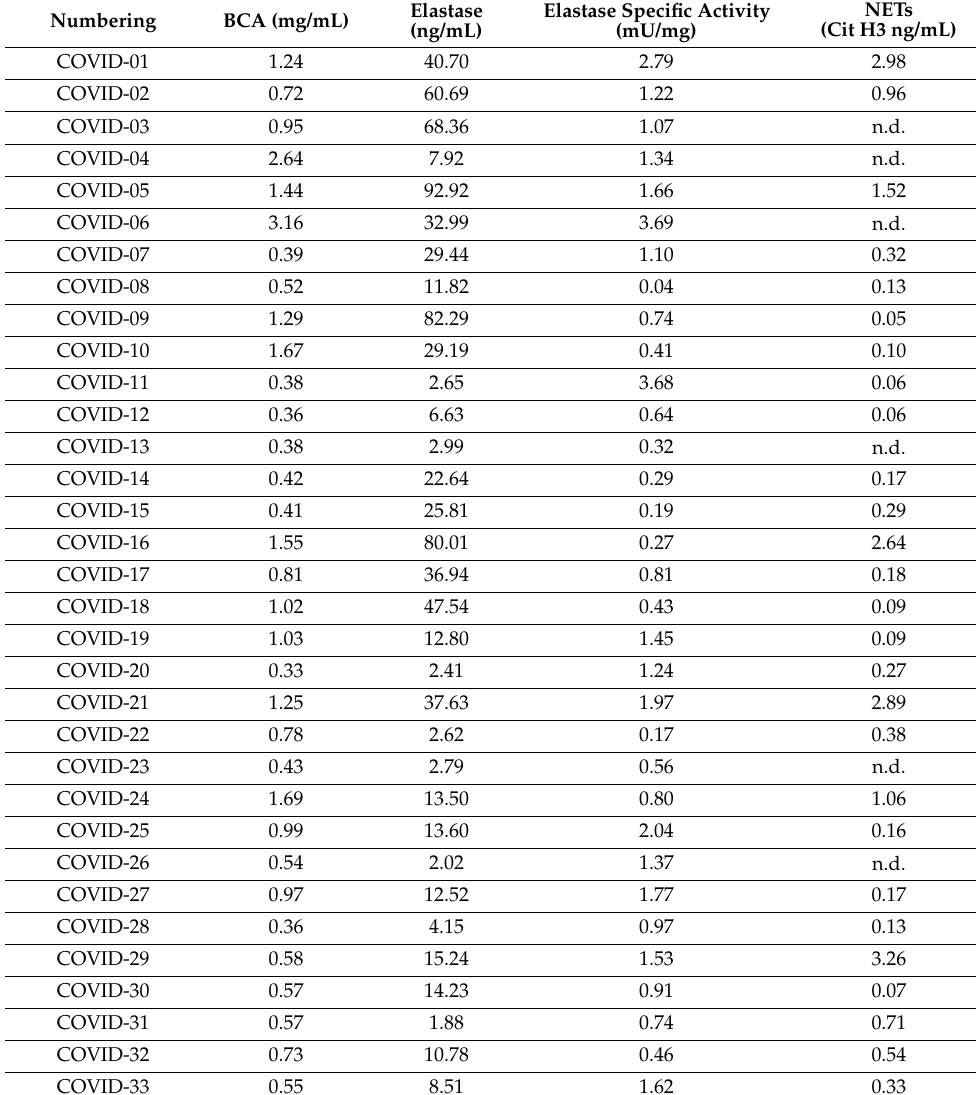
Values reported are the mean of three independent determinations. Standard deviation was within 5%. n.d. = not